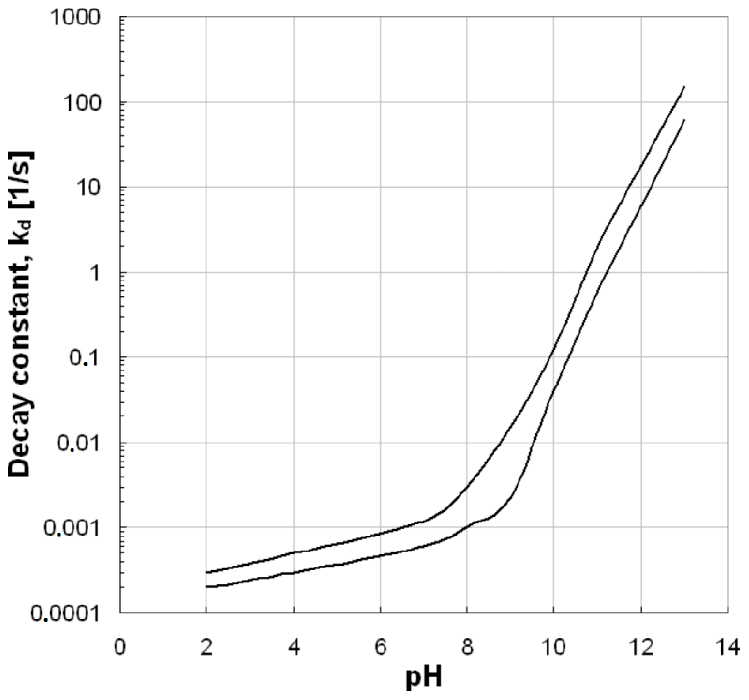
Figure 3. Ozone decomposition constant as a function of pH value [20].